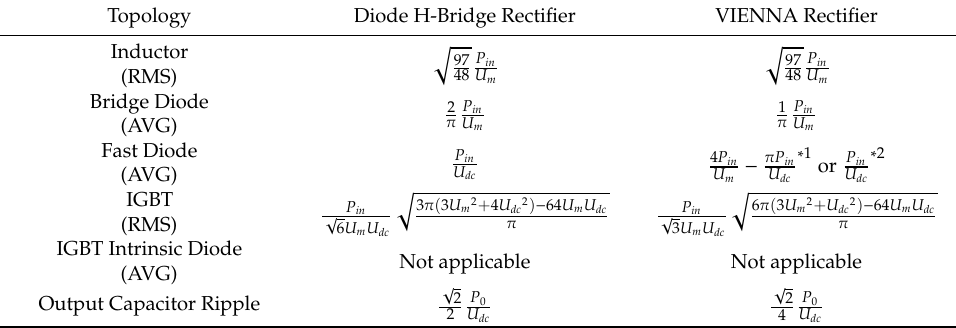
Table 5. The component current stress of diode H-bridge rectifier and VIENNA rectifier. Topology